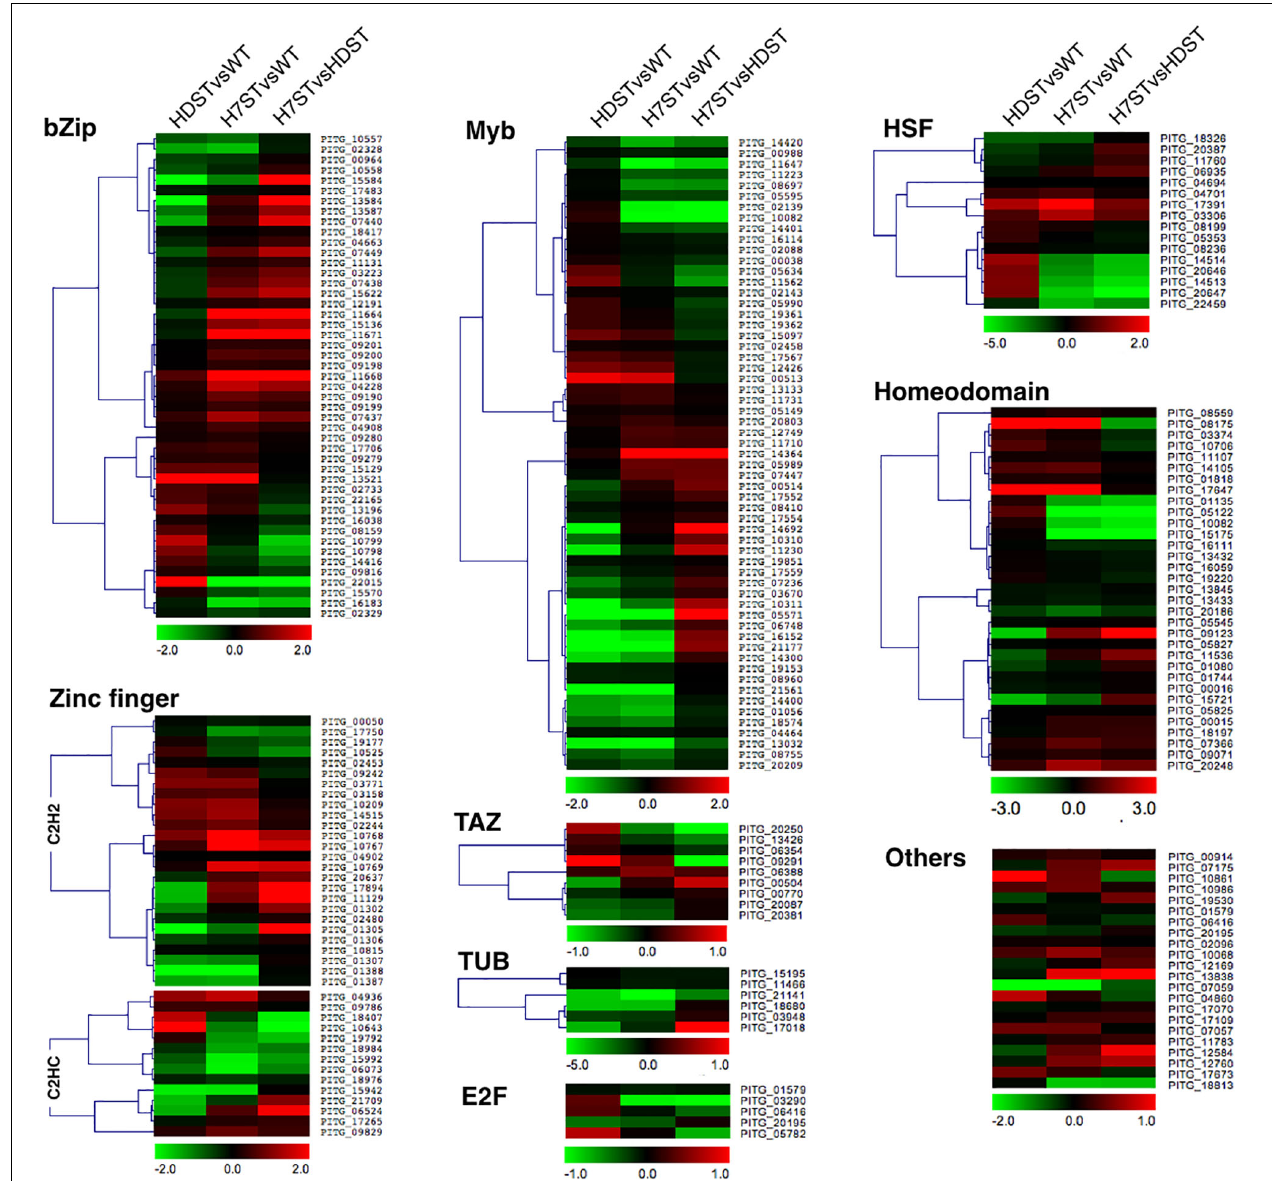
FIGURE 8 | Expression-level differences of transcription factor genes. Red and green denote genes with up- and down-regulated expression levels, respectively. The color bar represents the log 2 (fold-change)